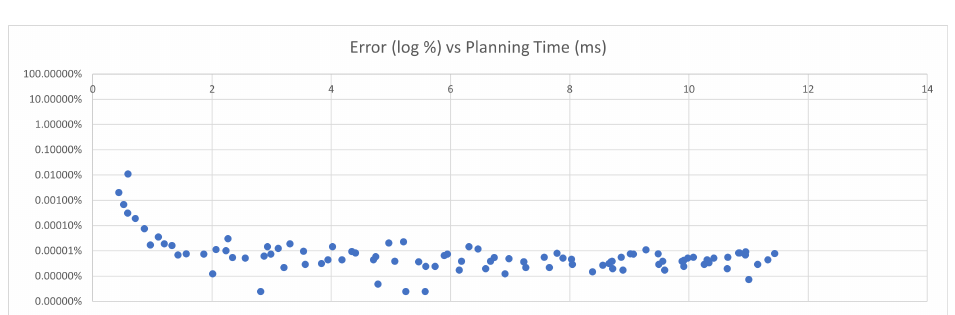
Figure 8. Log selectivity estimation error vs. planning time (ms).